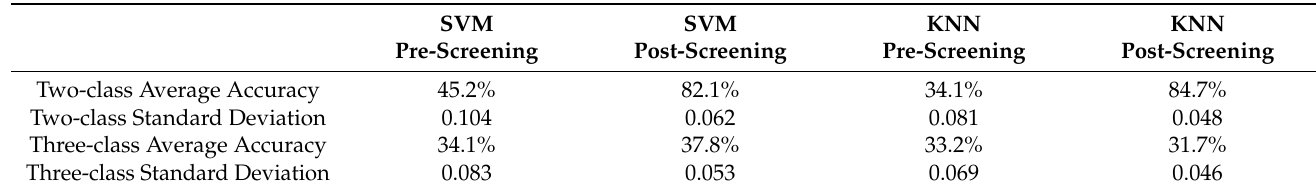
Table 1. The average accuracy and standard deviation of the test set for multiple verifications of the